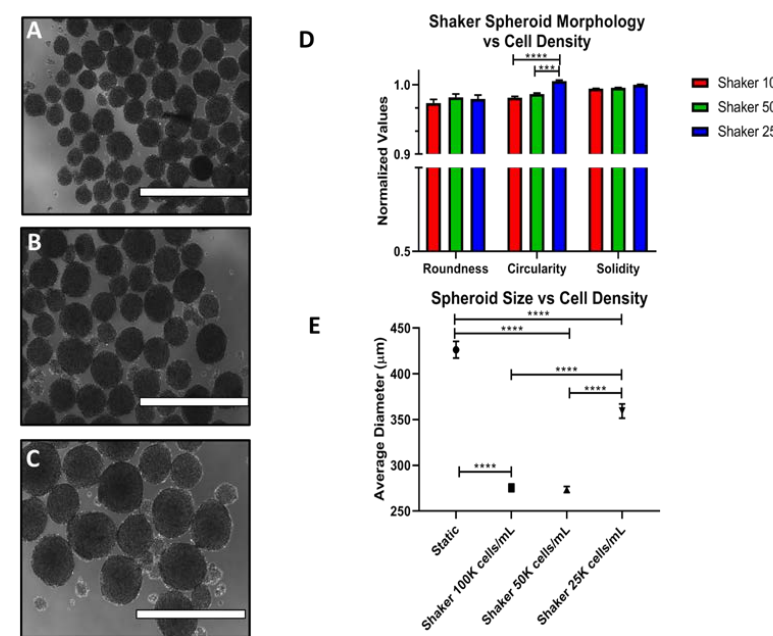
Figure 7. The effects of cell density on ES-2 spheroid properties under shaking conditions. Spheroid characteristics were monitored at 100,000 cells/mL ( A ), 50,000 cells/mL ( B ) and 25,000 cells/mL ( C ) for 72 h. ( D ) Quantification of roundness, circularity and solidity (RCS) values. ( E ) Quantification of spheroid size. Scale Bar: 1000 µm. ( n = 3). Cells 2018 , 7 , x FOR PEER REVIEW